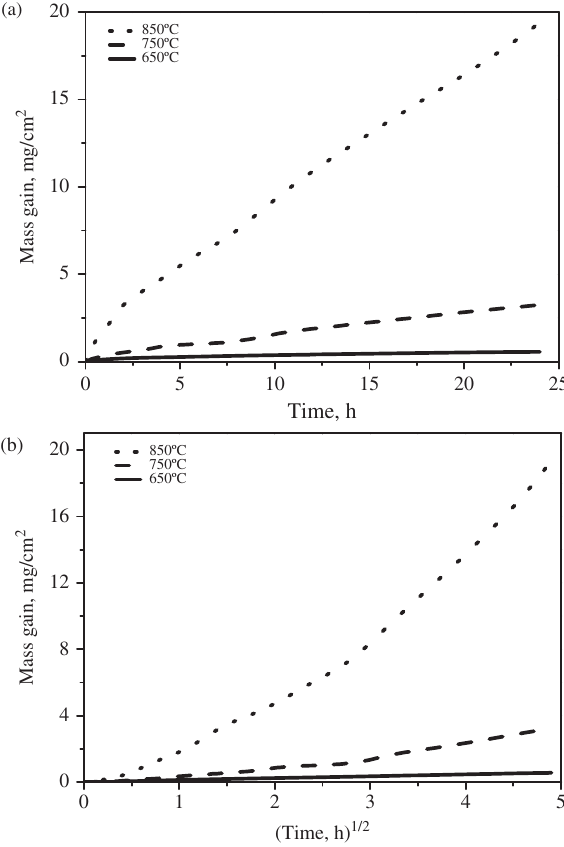
Figure 2: Kinetic curves for the oxidation of Ti-5Al-2.5Sn in air at 650, 750 and 850°C for 24 h: (a) linear plots; (b) parabolic